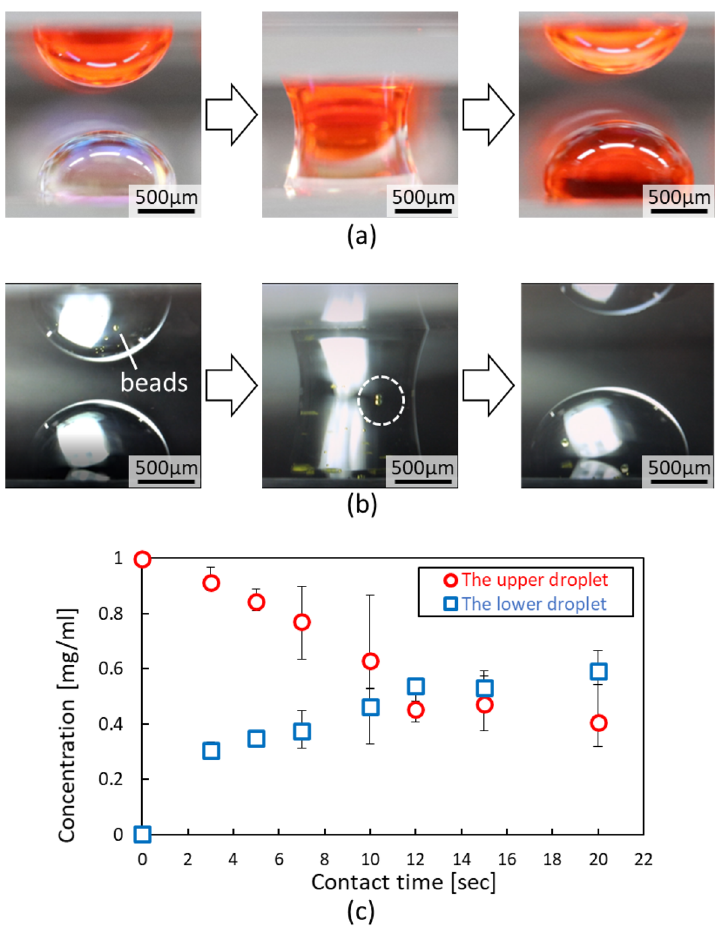
circular pattern 2.48 mm in diameter is 4 μl with an assumed contact angle of 90°. ( a ) Mixture by the contact fusion of an upper droplet of the red dye compound new coccine and a lower droplet of deionized (DI). Three sequential photographs show a droplet pair before contact, fused droplets, and a droplet pair after separation from the left. ( b ) Transport of particles between a droplet pair. Fluorescence beads moved from an upper droplet to a lower droplet through a fused contact. ( c ) Detailed evaluation of the mixture between the droplet pair in ( a ). The change in the concentration of substance in the droplet pair is further examined in accordance with the contact time. The concentration change of the red dye compound new coccine is evaluated for a longer time than in our previous report 25 . The concentrations of new coccine in the upper and lower droplets appear to asymptotically converge to the intermediate value, approximately 0.5 mg/ml. The concentrations of the upper and lower droplets continue to decrease and increase at a moderate rate, respectively, after the concentrations intersect at the intermediate